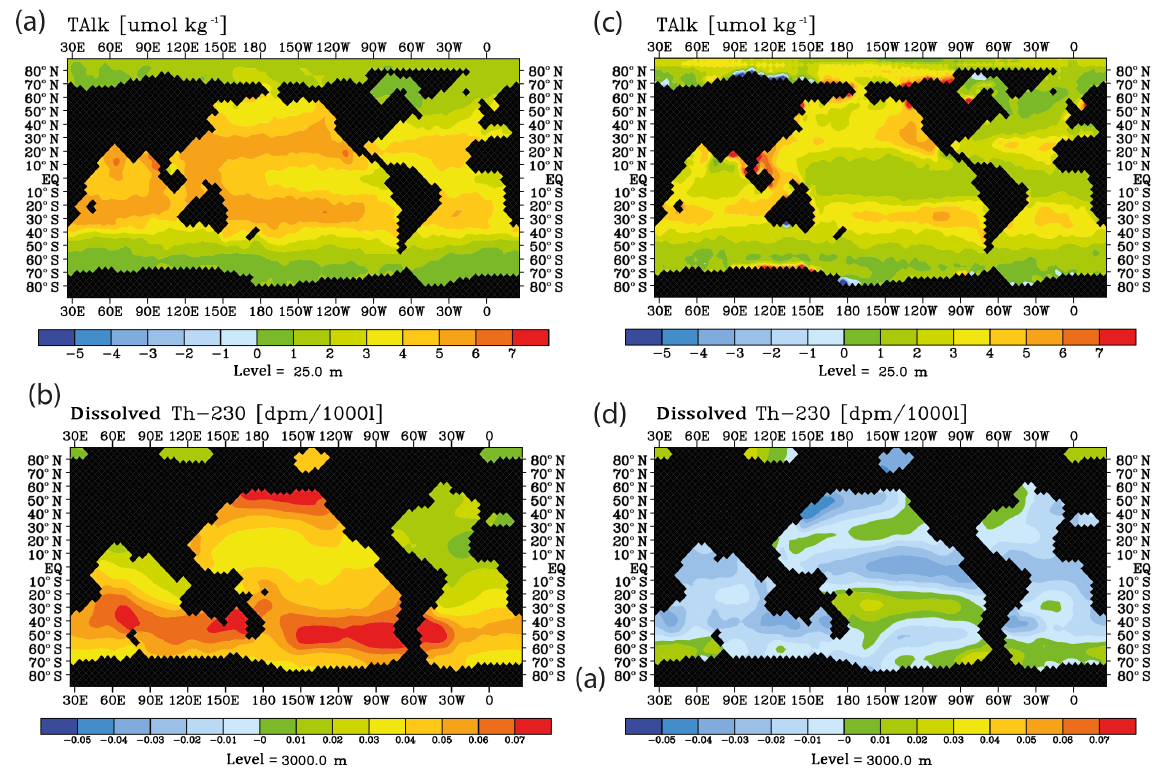
Figure 13. Surface alkalinity changes and deep 230 Th changes during 2040–2010 as for the RCP8.5 projection using moderate calcification changes. Left column without variability, (a) at the sea surface, (b) at 3000m. Right column with decadal parameter variability, (c) at the sea surface, (b) at